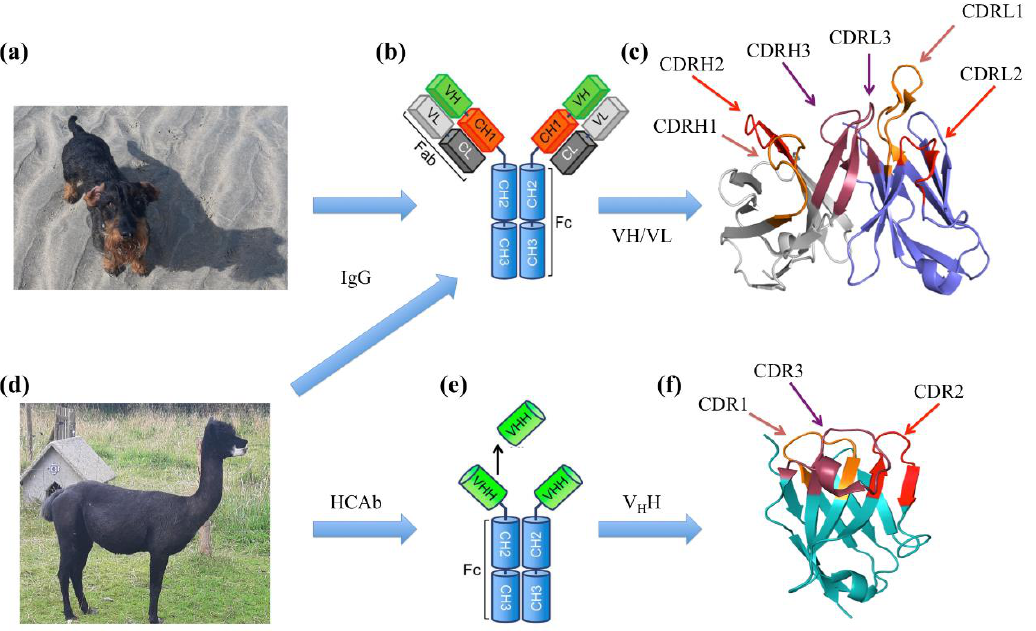
Figure 1. Antibody domains. Immunoglobulins are found in mammals such as the dachshund ( Canis familiaris ) named Snoopy ( a ) and a Vicuña ( d ); both pictures were taken in Normandy (France) in August 2021. The immunoglobulins are shown by domains in ( b ) Classical Immunoglobulin Gamma (IgG) and ( e ) HCAb (only found in the Camelidae family). ( c , f ) Antigen-binding domain of IgG and HCAb, namely the VH/VL domain and V H H domain. The FRs in the VH domain are shown in grey, in the VL domain in dark blue and in the V H H domain in cyan. The CDRs of the heavy chain are represented as CDRH1, CDRH2 and CDRH3, while CDRL1, CDRL2 and CDRL3 are CDRs of the light chain. The CDRs are represented in red shades: CDR1 (orange), CDR2 (red) and CDR3 (raspberry). Visualisation was performed using PyMOL [1–3]. Please notice that Snoopy was not harmed when taking these pictures and received an optimised dose of beef and turkey dog treats that he likes a lot.